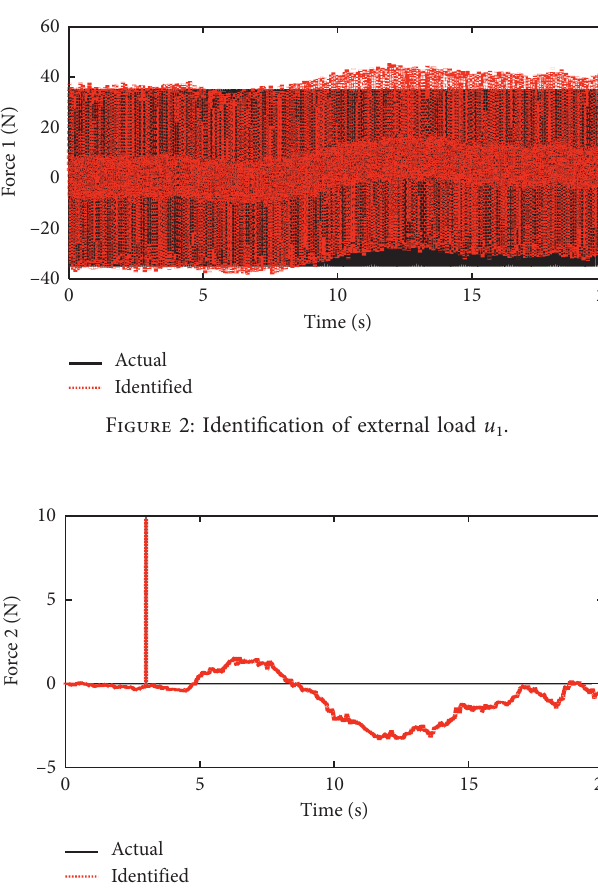
Figure 3: The actual and identified results of external load u